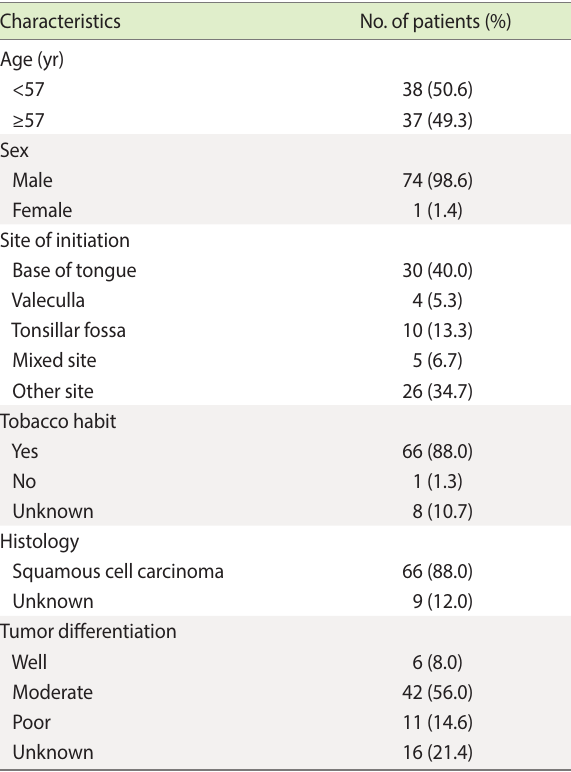
Table 4. Clinical and clinicopathological details of the oropharyn- geal cancer